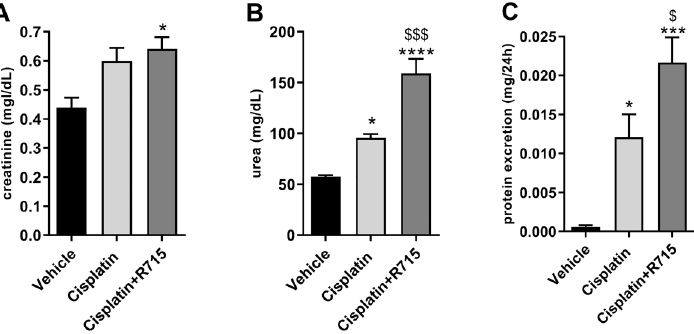
Figure 3. Kinin B1 receptor antagonism worsens cisplatin-induced renal dysfunction. Serum creatinine ( A ), urea ( B ), and protein excretion ( C ). Data are reported as means ± SE (n=6 per group). *P o 0.05, ***P o 0.001, ****P o 0.0001 compared to the vehicle group; $ P o 0.05, $$$ P o 0.001 compared to the cisplatin group (one-way ANOVA followed by post hoc Tukey ’ s test).